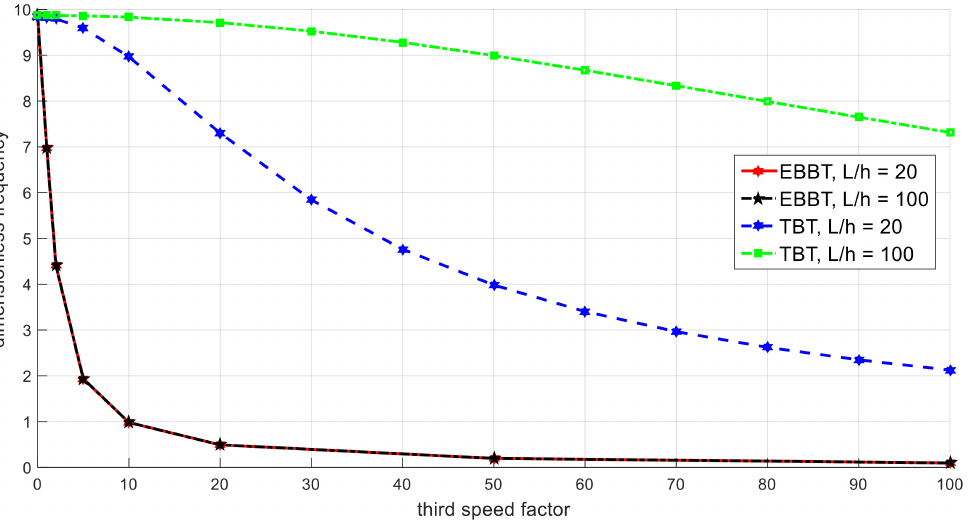
Figure 4. Variations of dimensionless fundamental frequency with angular speed factor.